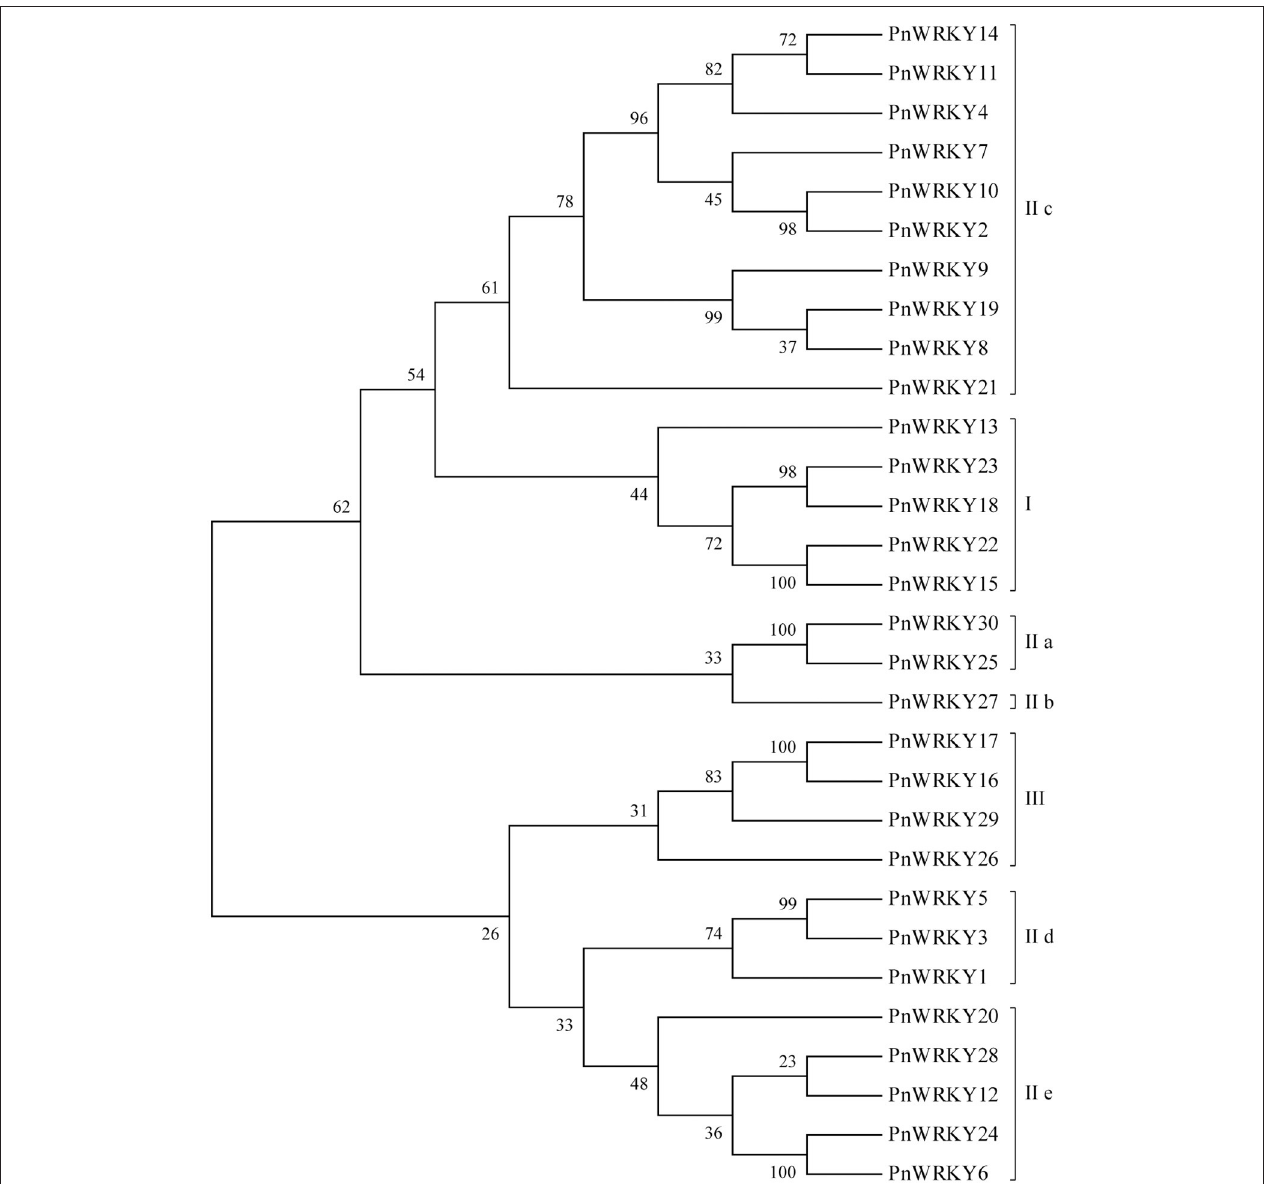
FIGURE 1 | Phylogenetic analysis of the Panax notoginseng WRKY family. The phylogenetic tree of P. notoginseng WRKY family was completed with MEGA6 software. The PnWRKYs were divided into groups I, II and III, in which the group II was further divided into five subgroups (IIa, IIb, IIc, IId, and IIe).